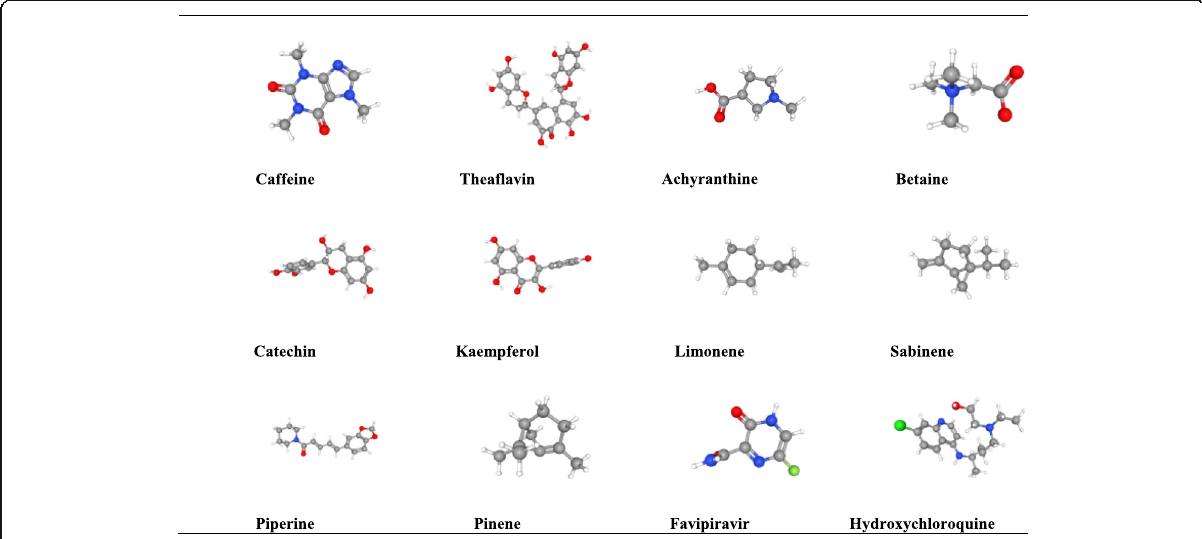
Fig. 1 3D chemical structure of selected ligands (caffeine, theaflavin, achyranthine, betaine, catechin, kaempferol, limonene, sabinene, piperine, pinene, favipiravir,